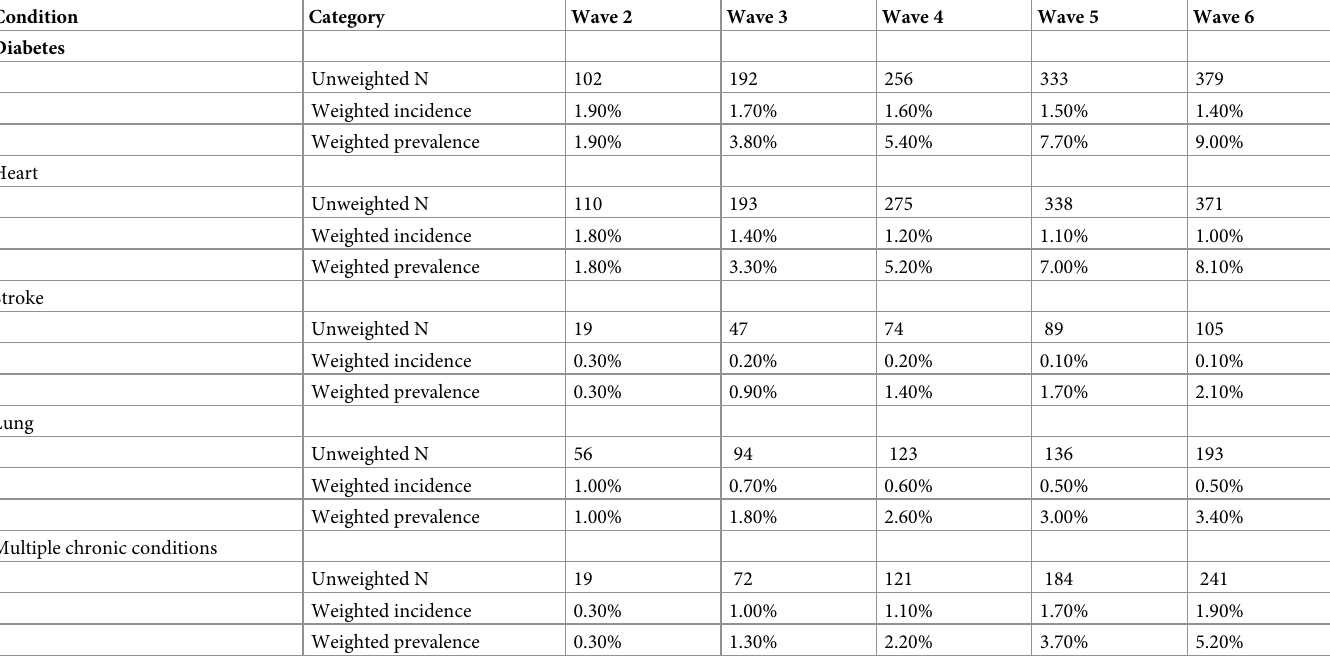
Table 1. Incidence and prevalence of diabetes, heart disease, stroke, lung disease, and multiple chronic conditions by follow-up wave.